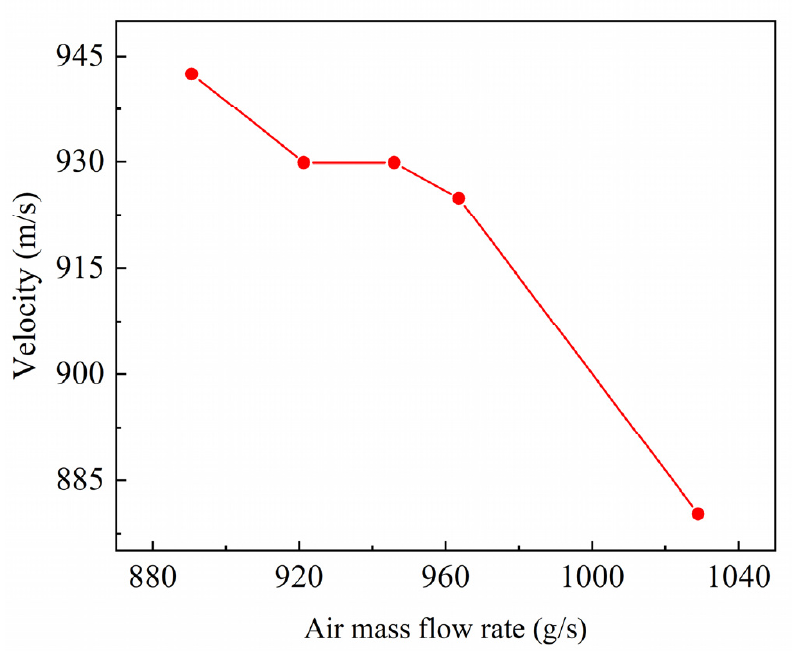
Figure 3. Variation of wave speed with air mass flow rate (mass fraction of H 2 12%).